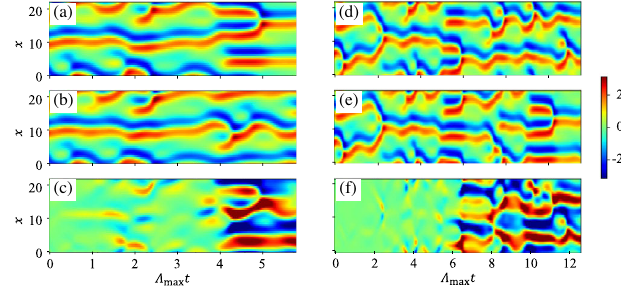
FIG. 7. Kuramoto-Sivashinsky spatiotemporal chaotic datasets prediction by conventional reservoir computing that models (a) – (c) the standard intensity readout activation function and (d) – (f) the appropriately tuned hyperbolic tangent nonlinear function applied on it. (a),(d) Actual datasets. (b),(e) Reservoir predictions. (c),(f) Errors. The spatial domain size of the chaotic system and the number of the photonic nodes in the reservoir are the same as in Fig. and W for both activation functions are initialized with a in zero mean value, while their standard deviations for the intensity readout are 0.78 and 0.41, respectively, and for the hyperbolic tangent activation function are 0.9 and 0.54, the grid search to optimize the prediction performance.